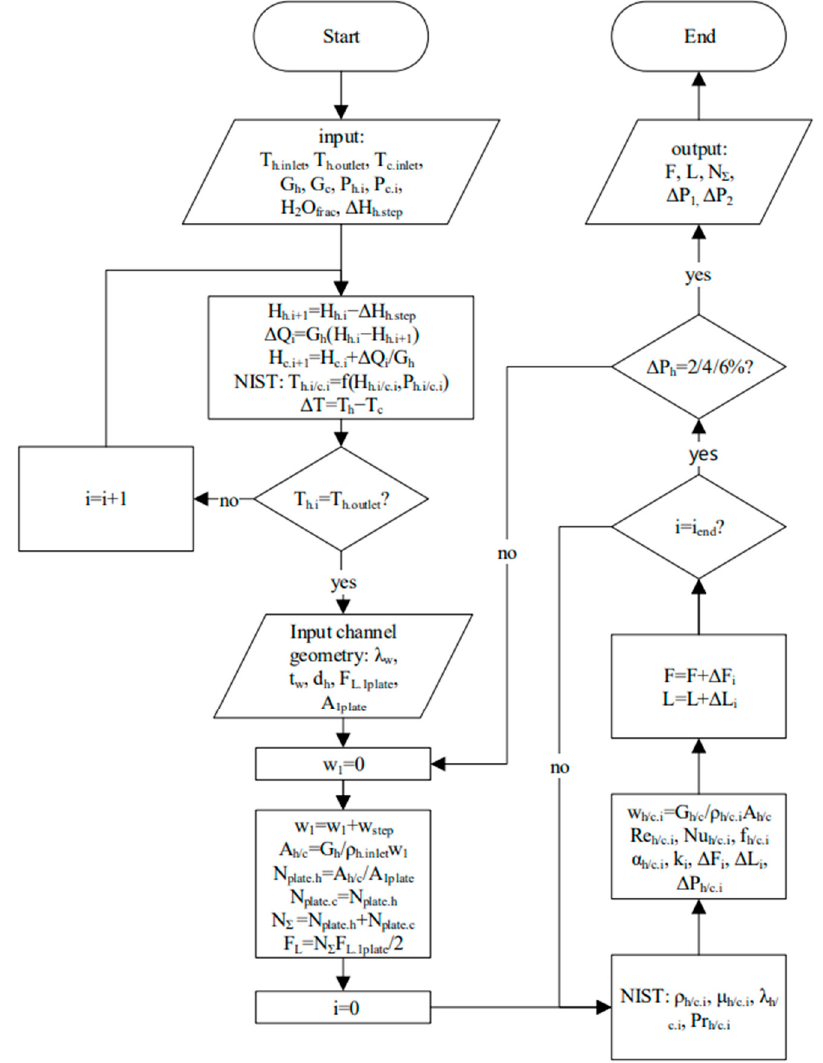
Figure 6. Algorithm for the design calculation of the regenerator.